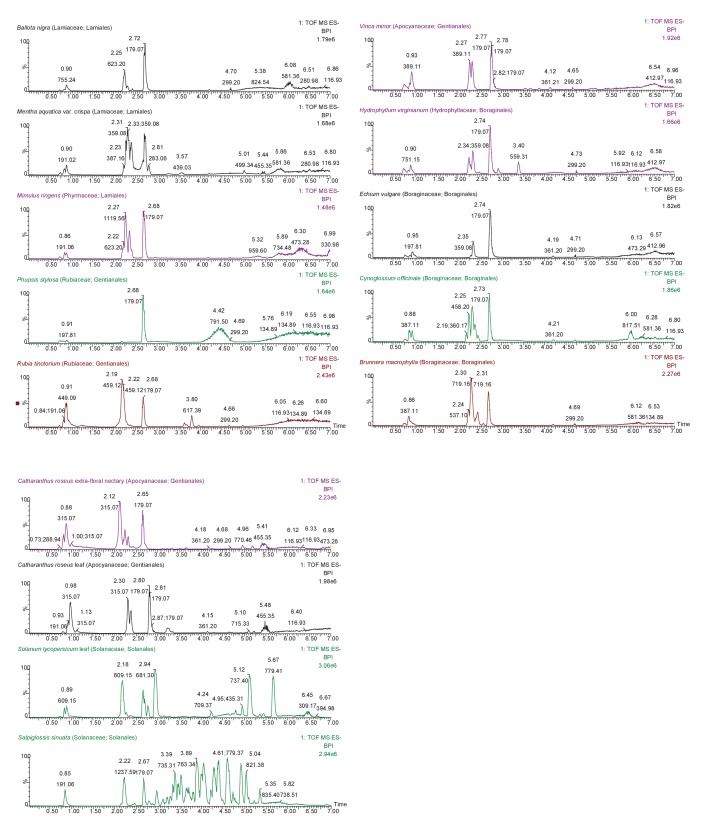
LC/MS profiles of leaf surface metabolites from 11 species from the Gentianales, Lamiales, Boraginales orders collected from the living collection at the MSU Botanical Gardens.Positive controls S. lycopersicum M82 and Salpiglossis sinuata are also included. Samples were run on a C18 column as described in the Methods. These profiles show that peaks with m/z ratios consistent with acylsugars are found only in the Solanaceae species.